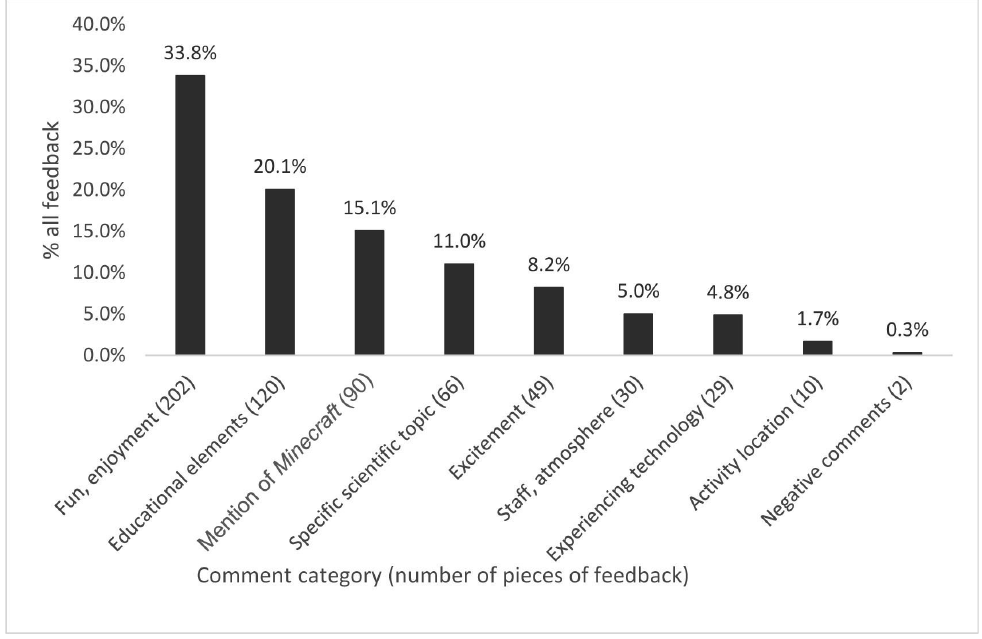
Figure 8: Distribution of comments between categories for feedback given via word walls and feedback